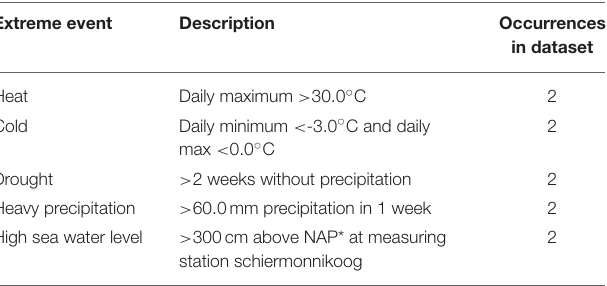
TABLE 2 | Criteria used to identify extreme events of different abiotic variables, and the frequency of these events for the full sampling period. Extreme event